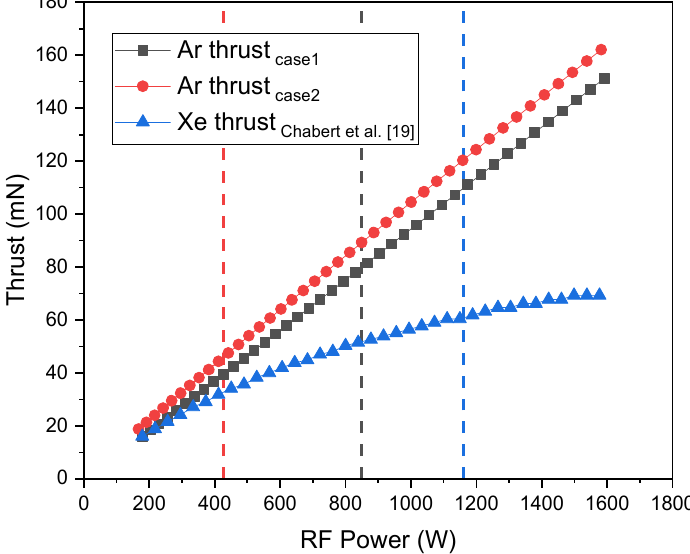
Figure 8. Comparison of the thrust produced by Ar ions calculated by global model with (case 1) and without (case 2) the complete set of reactions as a function of RF Power. The data in blue were adapted from Chabert et al. [19] and are relative to global model of xenon plasma thruster. Pressure = 2 mTorr.